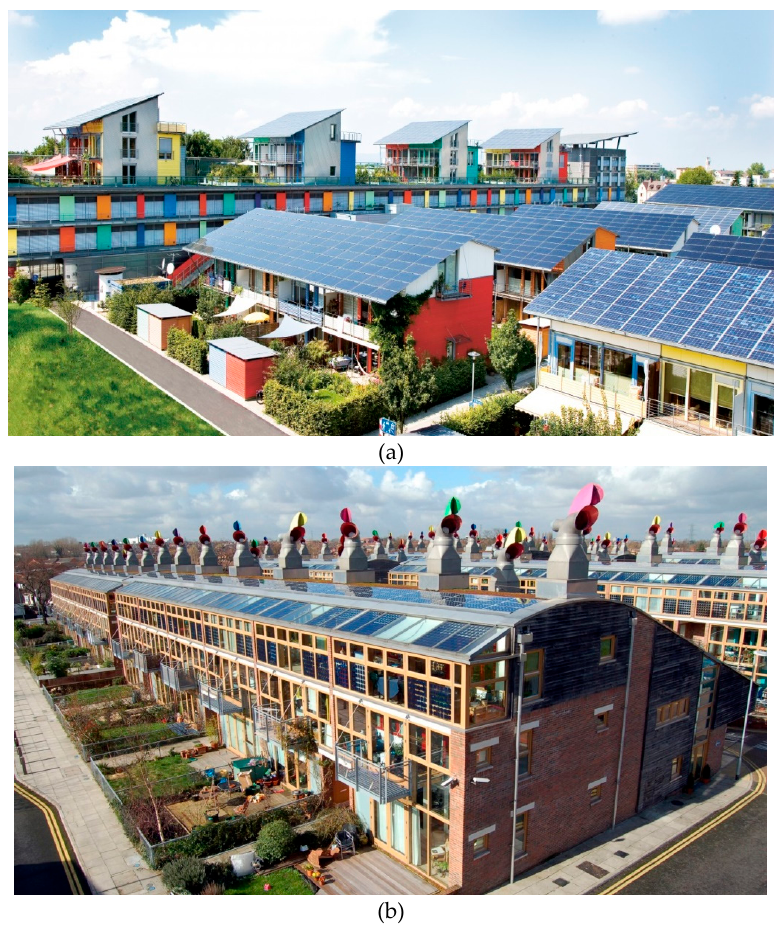
Figure 11. ( a ) The energy plus solar housing settlement at Freiburg by ROLF DISCH, Germany, [146] . ( b ) Beddington Zero Energy Development (BedZED), London, UK, [147] .